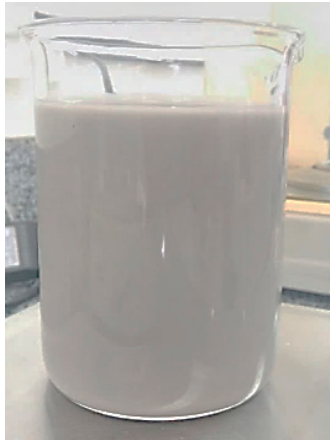
Figure 3. Developed drilling fluid (EDF).